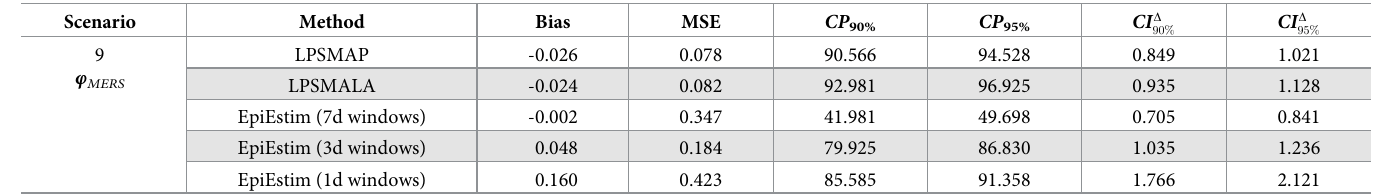
is reported at the end of the window. t